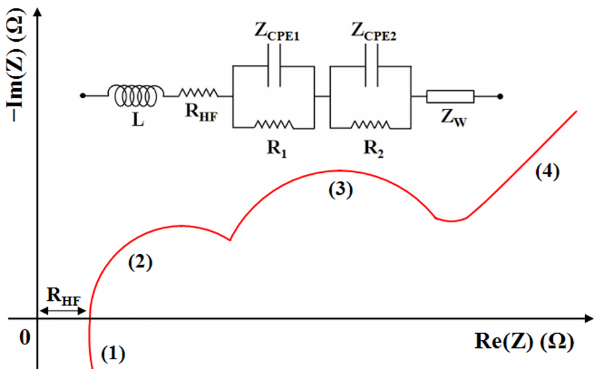
Figure 11. Equivalent circuit and Nyquist plot of a lithium–ion bat- tery